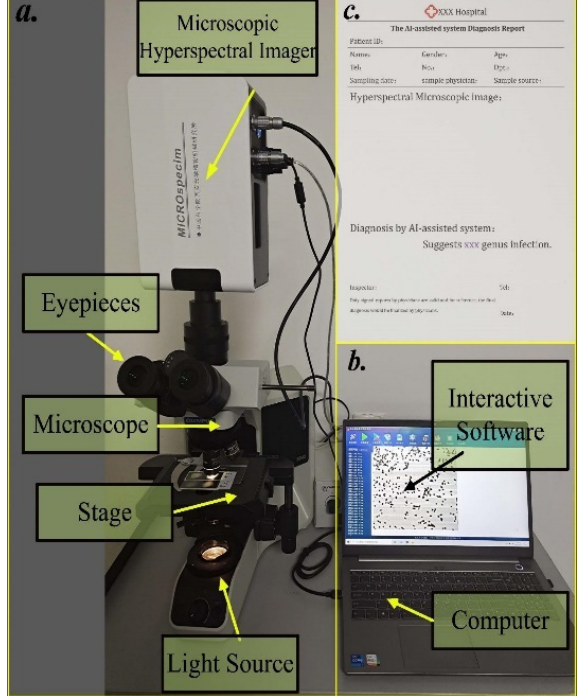
Figure 2. The components of the integrated AI-assisted system. ( a ) The HMI system. It is composed of a microscope and hyperspectral camara and is responsible for detecting and imaging the view containing bacteria. ( b ) The host, where data storage processing, bacteria identification and interaction are deployed. ( c ) A template for the PDF files, i.e., the diagnostic report, output by the AI-assisted system.